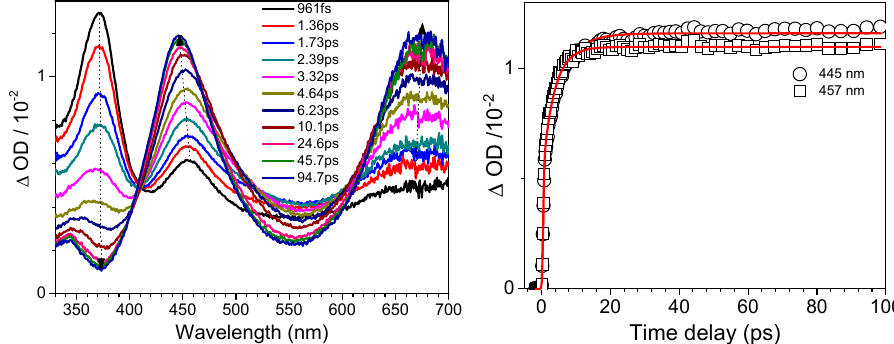
Figure 1. Displayed are femtosecond transient absorption (fs-TA) spectra of DN in acetonitrile (MeCN) acquired after 267 nm irradiation ( left ), and kinetics of the band at 445 nm and 457 nm ( right ).